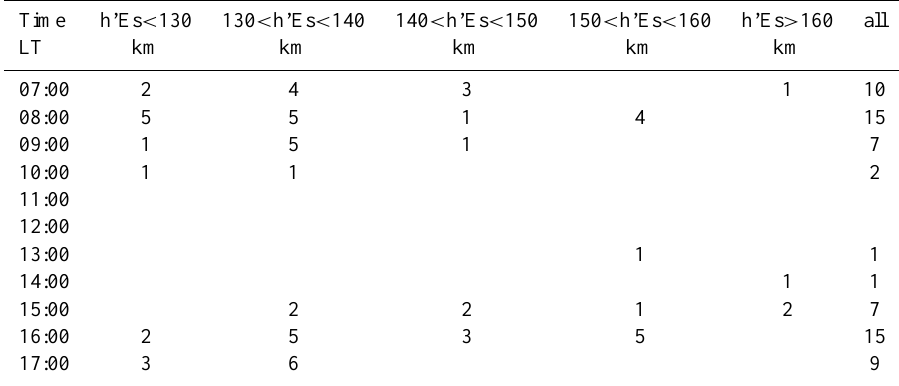
Table 4. Occurrence of sporadic Es layer, type h (Rome station, September–October 1997).